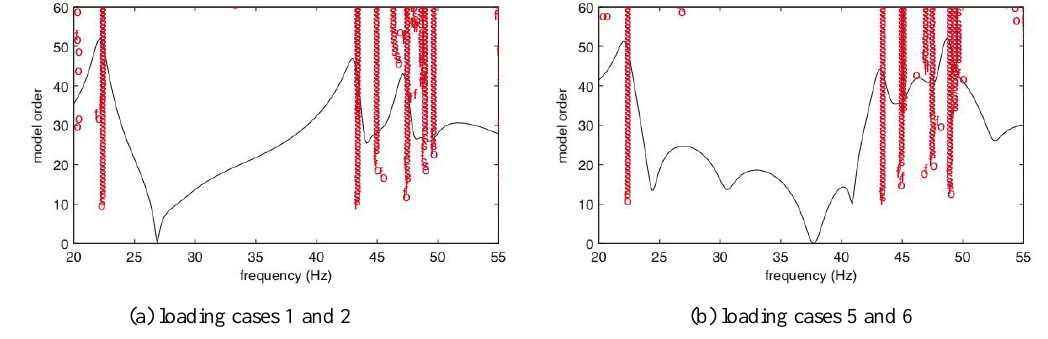
Fig. 8. Transmissibility driven stabilisation diagrams: Combining different loading